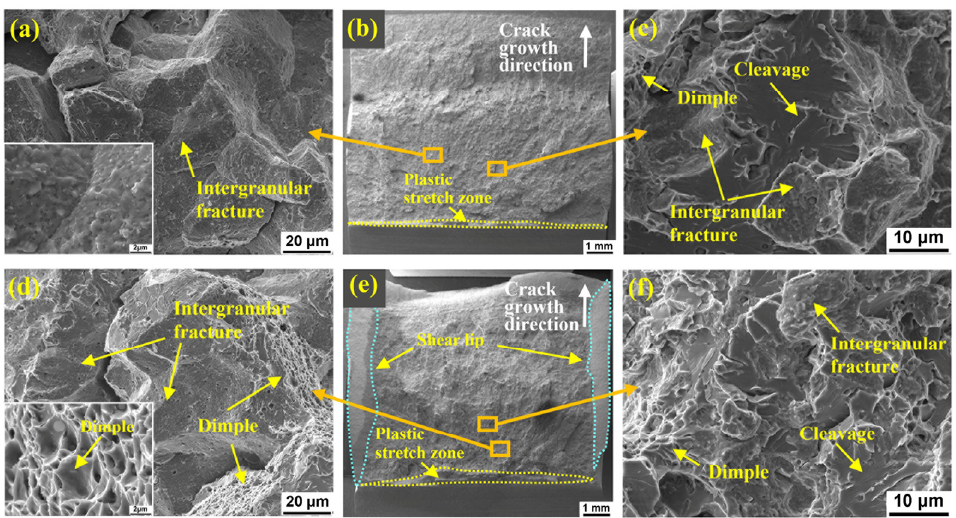
Figure 8. The impact fracture morphology of the WMs: ( a – c ) the turbine part (15 J); ( d – f ) the compressor part (38 J).